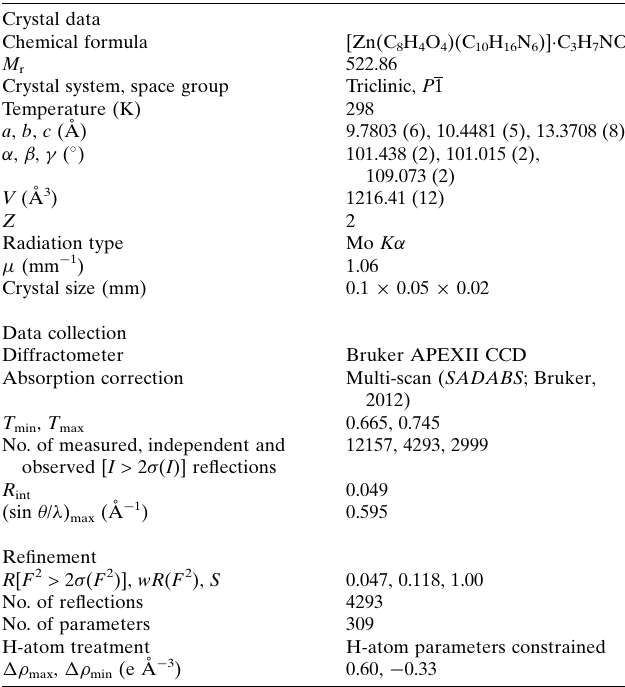
Table 2 Experimental details. Crystal data Chemical